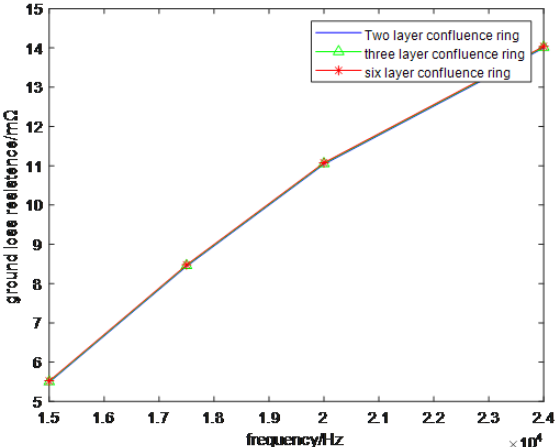
Figure 7. Ground loss resistors with different layers of manifold rings.